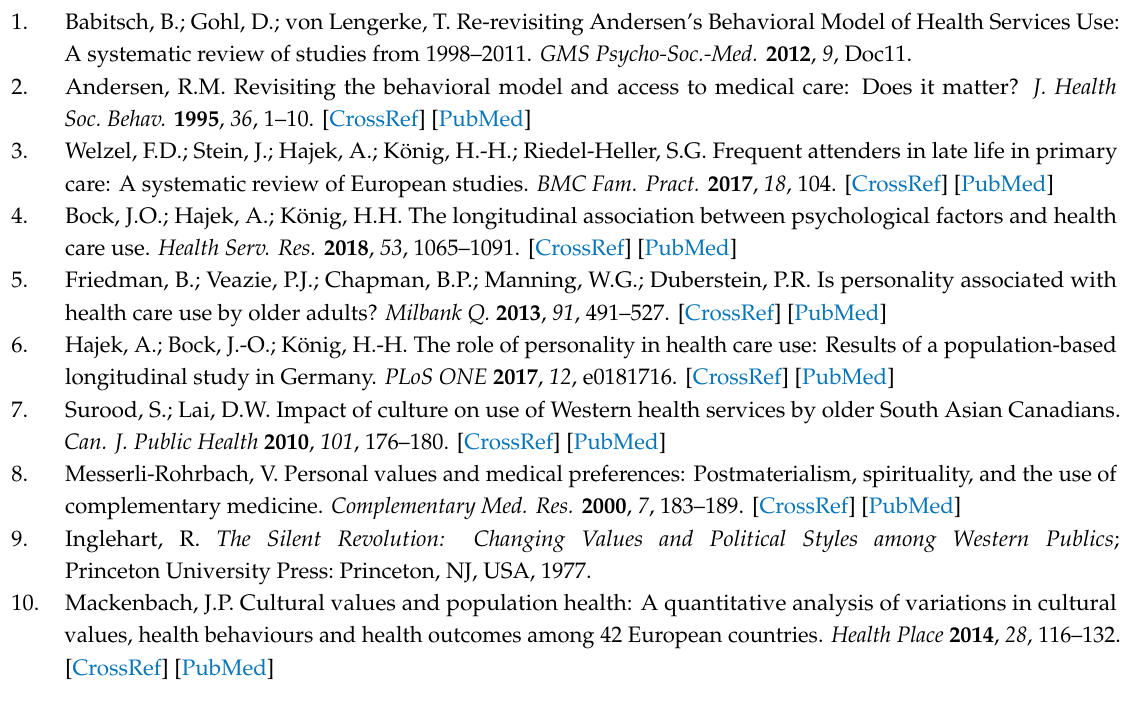
Table S1: Sample characteristics for the individuals included in negative binomial regressions stratified by sex and materialism / post-materialism status ( n = 3338), Table S2: Determinants of frequency of physician visits (total sample and stratified by sex). Results of Poisson regressions, Table S3: Determinants of frequency of physician visits (total sample and stratified by sex). Results of negative binomial regressions (also displaying the coe ffi cients for the covariates), Table S4: Determinants of seeing the doctor (for several reasons). Results of logistic regressions (1 = yes, visiting the doctor for this reason; 0 = otherwise) (also displaying the coe ffi cients for the covariates), Table S5: Determinants of frequency of physician visits (total sample and stratified by sex). Results of negative binomial regressions (with ‘Post-materialist’ as reference category), Table S6: Determinants of seeing the doctor (for several reasons). Results of logistic regressions (1 = yes, visiting the doctor for this reason; 0 = otherwise) (with ‘Post-materialist’ as reference category), Table S7: Determinants of frequency of physician visits (total sample and stratified by sex). Results of negative binomial regressions (main model extended by (log) household net equivalent income), Table S8: Determinants of seeing the doctor (for several reasons). Results of logistic regressions (1 = yes, visiting the doctor for this reason; 0 = otherwise) (main model extended by (log) household net equivalent income), Table S9: Determinants of frequency of physician visits (total sample and stratified by sex). Results of negative binomial regressions (main model extended by employment status), Table S10: Determinants of seeing the doctor (for several reasons). Results of logistic regressions (1 = yes, visiting the doctor for this reason; 0 = otherwise) (main model extended by employment status), Table S11: Determinants of frequency of physician visits (total sample and stratified by sex). Results of negative binomial regressions (main model extended by monthly dummies), Table S12: Determinants of seeing the doctor (for several reasons). Results of logistic regressions (1 = yes, visiting the doctor for this reason; 0 = otherwise) (main model extended by monthly dummies), Table S13: Determinants of frequency of physician visits (total sample and stratified by sex). Results of negative binomial regressions (main model extended by town size), Table S14: Determinants of seeing the doctor (for several reasons). Results of logistic regressions (1 = yes, visiting the doctor for this reason; 0 = otherwise) (main model extended by town size), Table S15: Determinants of frequency of physician visits (total sample and stratified by sex). Results of negative binomial regressions (main model stratified by age